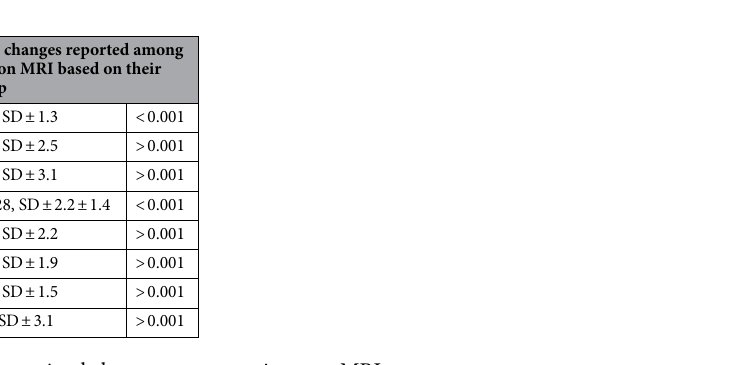
Table 2. Studies reporting meniscal changes among patients on